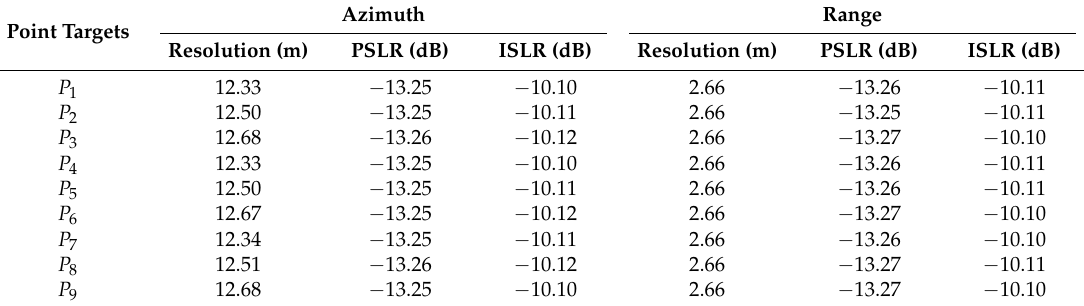
Table 3. Quantitative analysis of the imaging